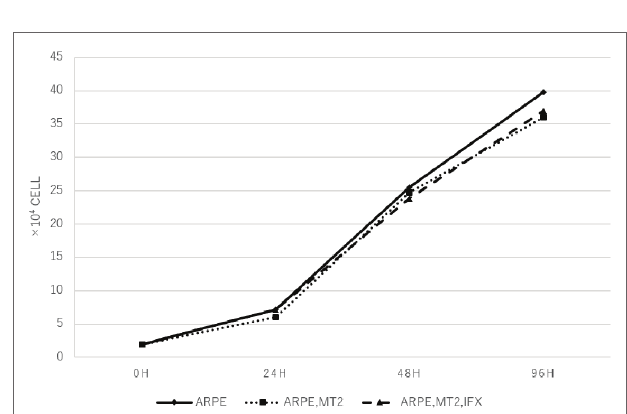
FIGURE 2 | The number of ARPE-19 cells per well at 0, 24, 48, and 96 h. ARPE-19 cells increase in a time-dependent manner and no significant differences among the number of ARPE-19 cells co-cultured with MT2 cells with or without IFX are seen at each point. We conducted independent experiments and plotted the average